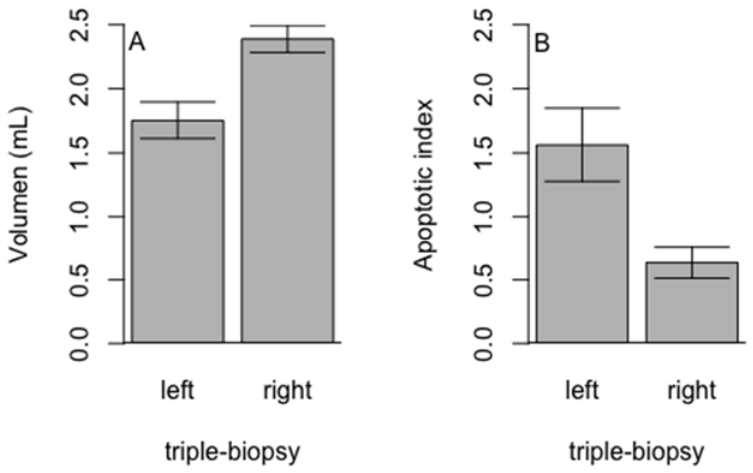
Figure 9. Comparison of the ( A )—volume and ( B )—apoptotic index of the left (punctured) and right (intact) testicles in triple biopsy group (Student t -test, p < 0.01). Higher percentage of atrophic tubules has been found in the group of left (biopted) testicles compared to the right (intact) testicles in single-biopsy ( p < 0.001) and triple- biopsy ( p < 0.001) groups (Figure 10). Figure 10. Comparison of atrophic tubules between the left and right testicles in single and triple- biopsy groups (Mann–Whitney U test, p < 0.001). The value of Johnsen score was significantly lower in the left (biopted) testicles compared to the right (intact) testicles in both single-biopsy ( p < 0.001) and triple-biopsy ( p < 0.001) groups (Figure 11).